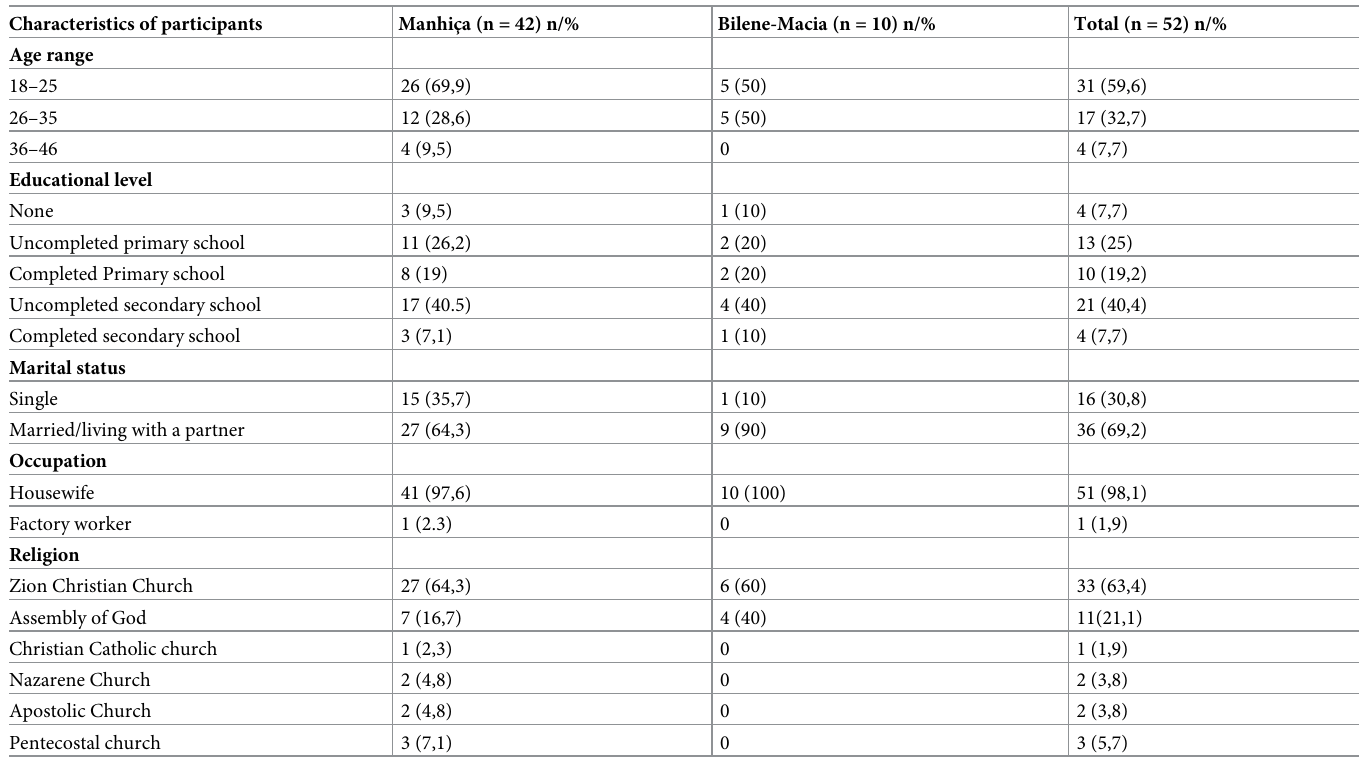
Table 4. Sociodemographic characteristics of caregivers. Characteristics of participants